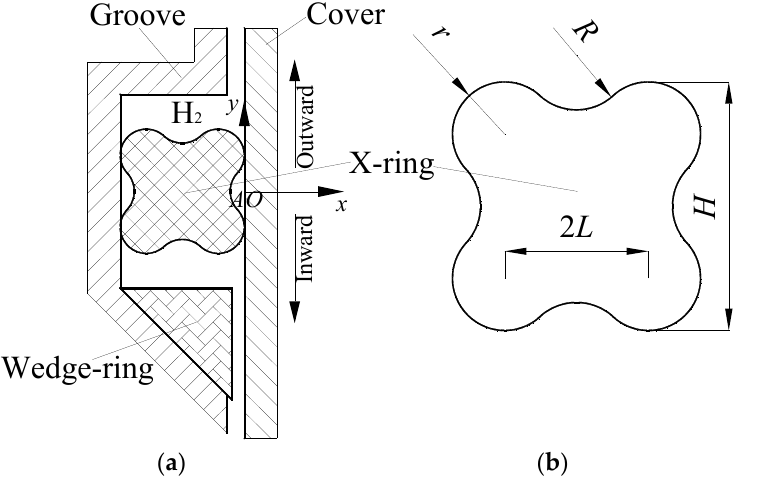
Figure 1. Details of the seal component. ( a ) Schematic of the rubber X-ring seal structure; ( b ) Geometric parameters of X-ring.